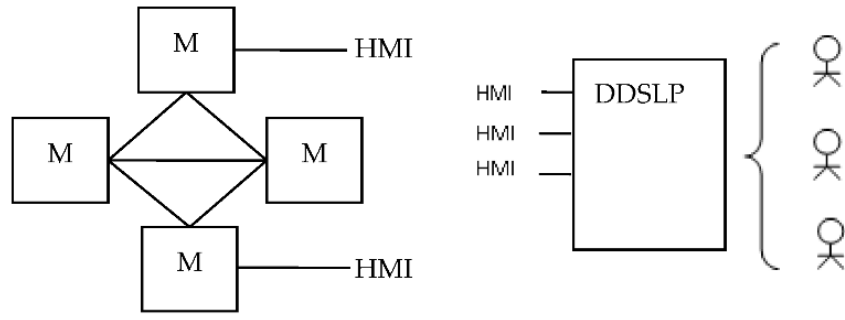
Figure 1. DTS generalized structure.